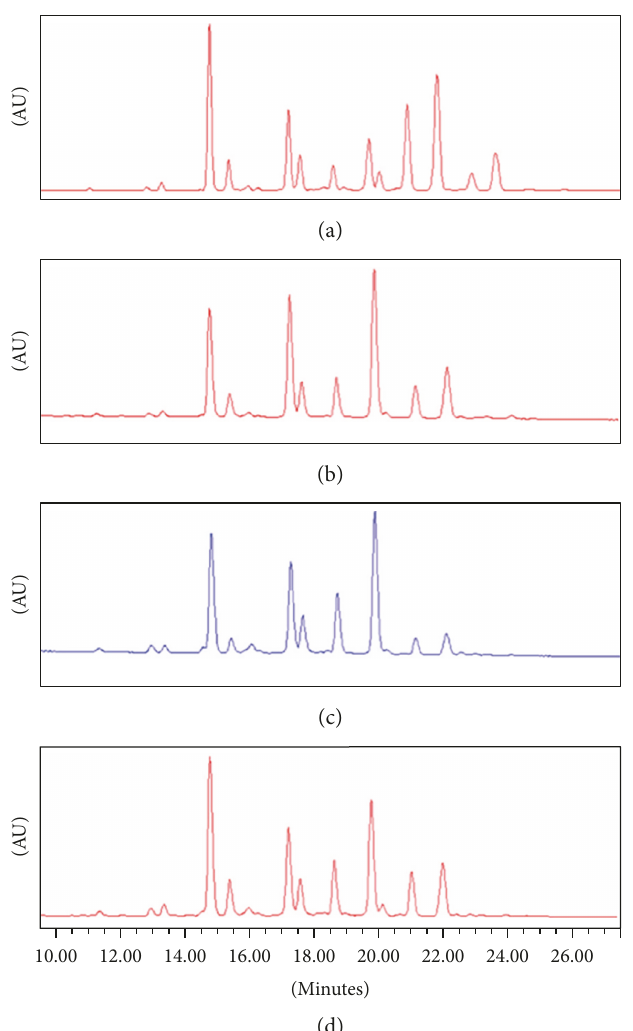
Figure 1: Figure 3(b) from Miranda-Hernandez et al. 2016 [1]. Glycan heterogeneity by HILI-UPLC of In fi nitam (c) and the reference product (a, b, d). Chromatograms have been labelled (a – d) for this